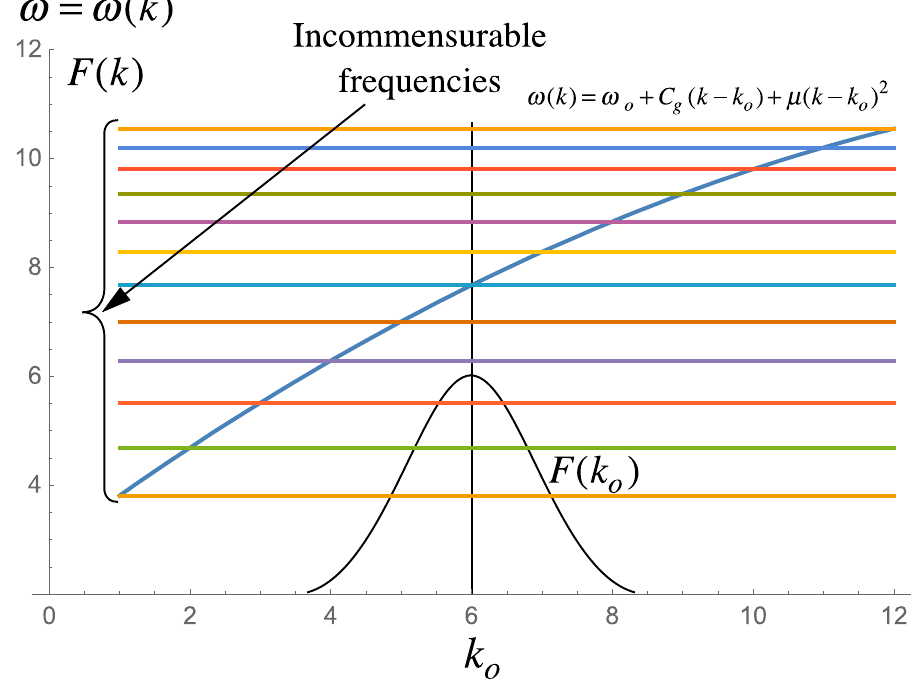
Figure 21. Comparison of linear, deep-water dispersion ω = gk (blue) with the dispersion relation of the 1 + 1 NLS Equation (181) (brown). The two agree rather well with each other near the peak of the spectrum.